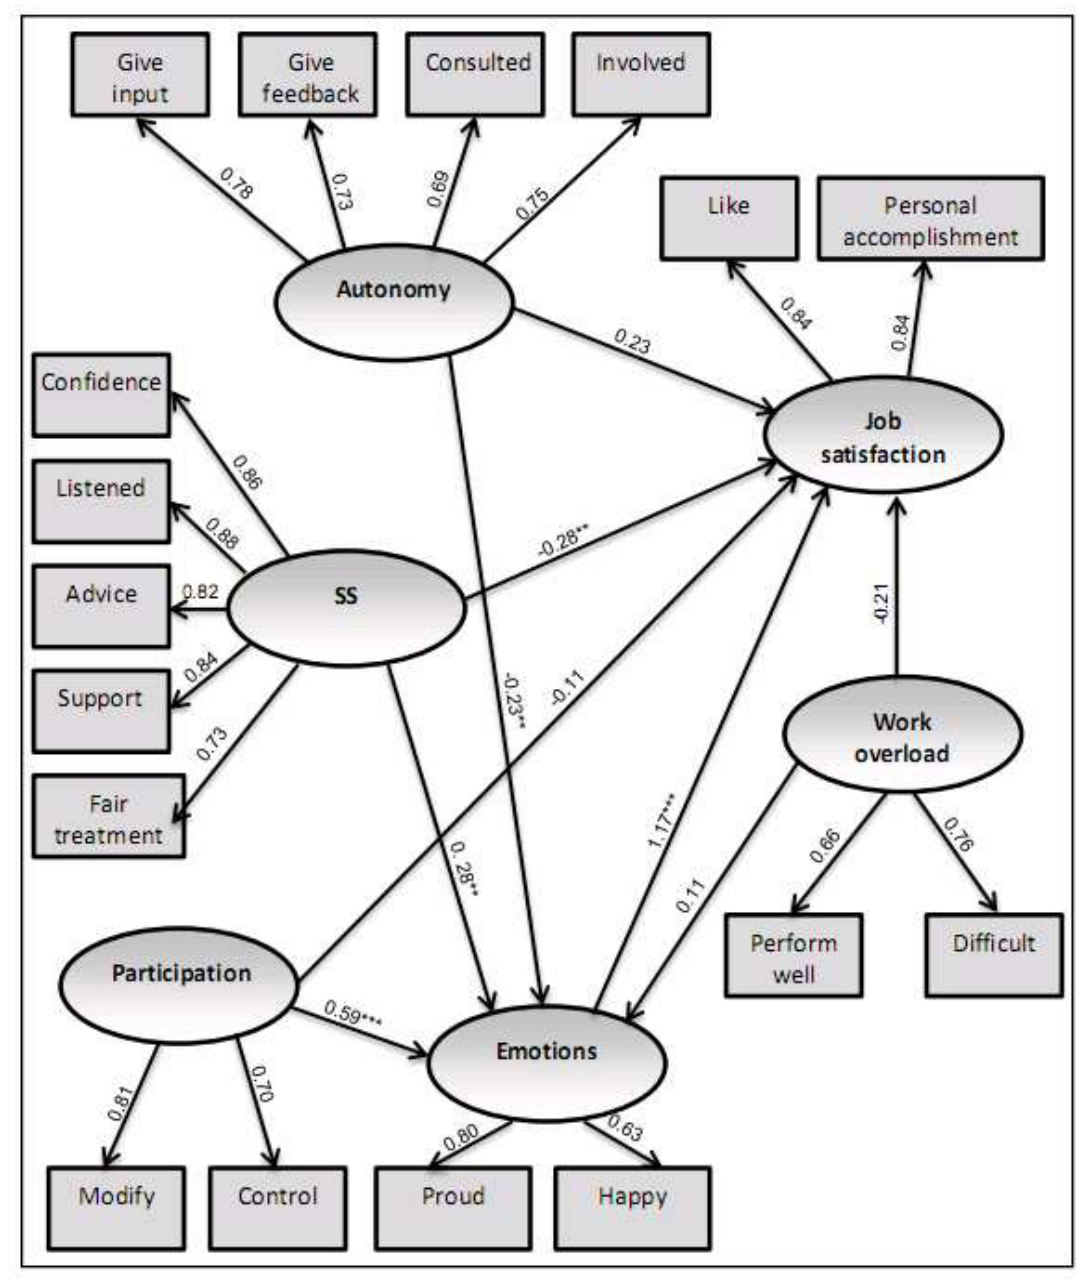
Fig. 2. Structural equation